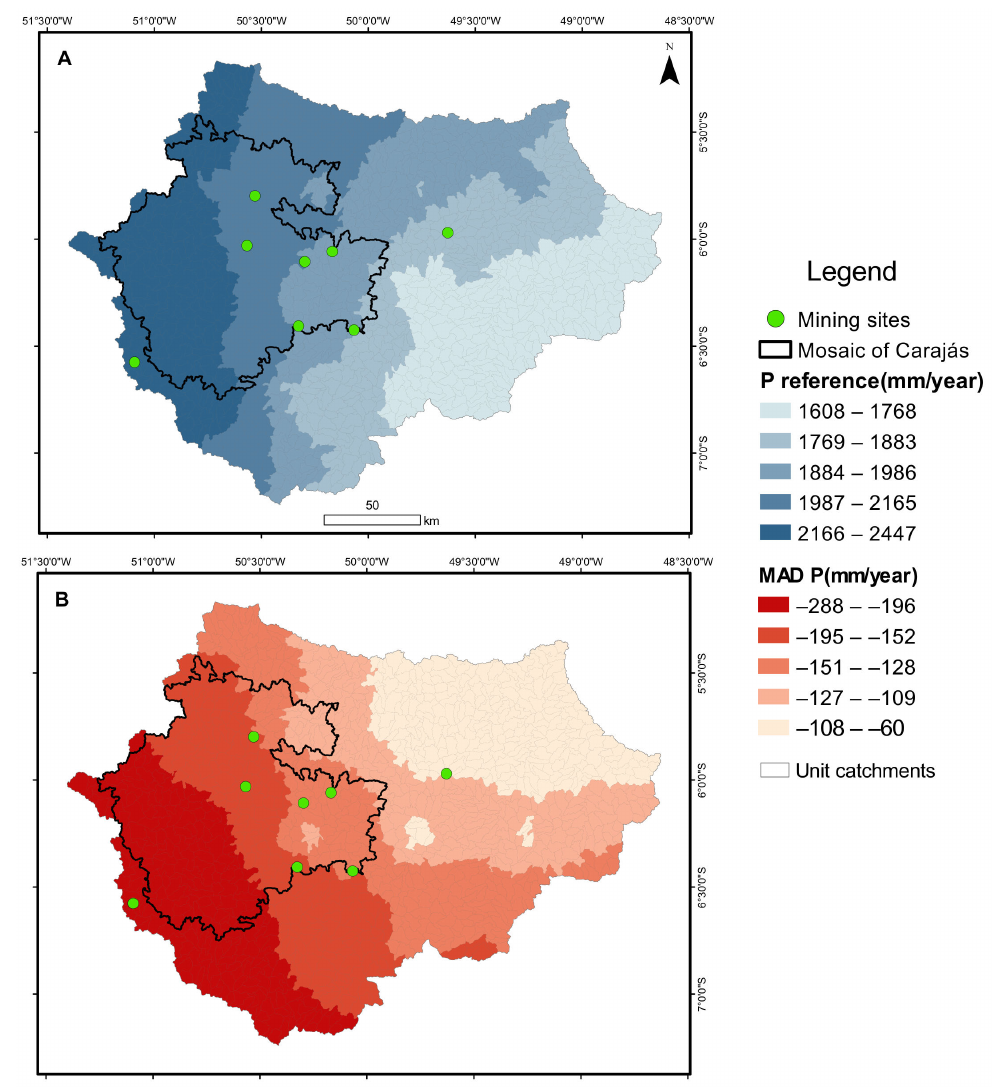
Figure 6. ( A ) Mean annual precipitation P (mm/year) for the reference period; and ( B ) mean absolute differences (mm/year) of mean annual precipitation between the future (mGCMs) and reference periods for the RCP8.5 scenario (we decided not to show the results of RCP4.5 because the results showed similar spatial